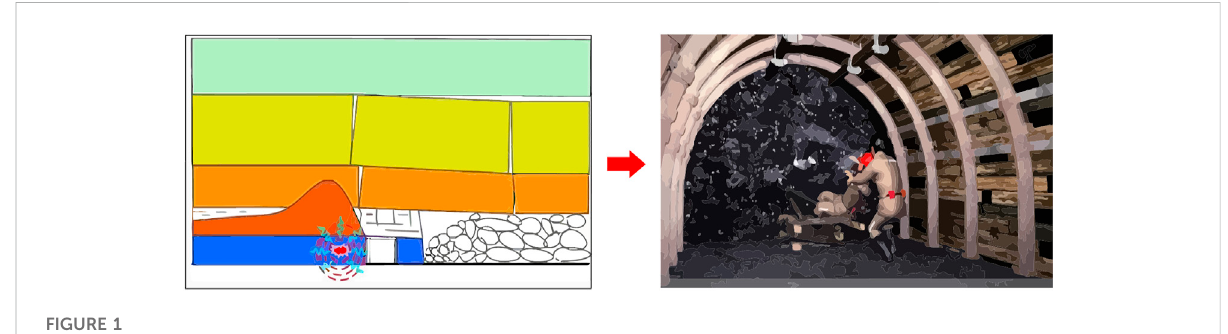
FIGURE 1 Schematic diagram of rock and coal burst